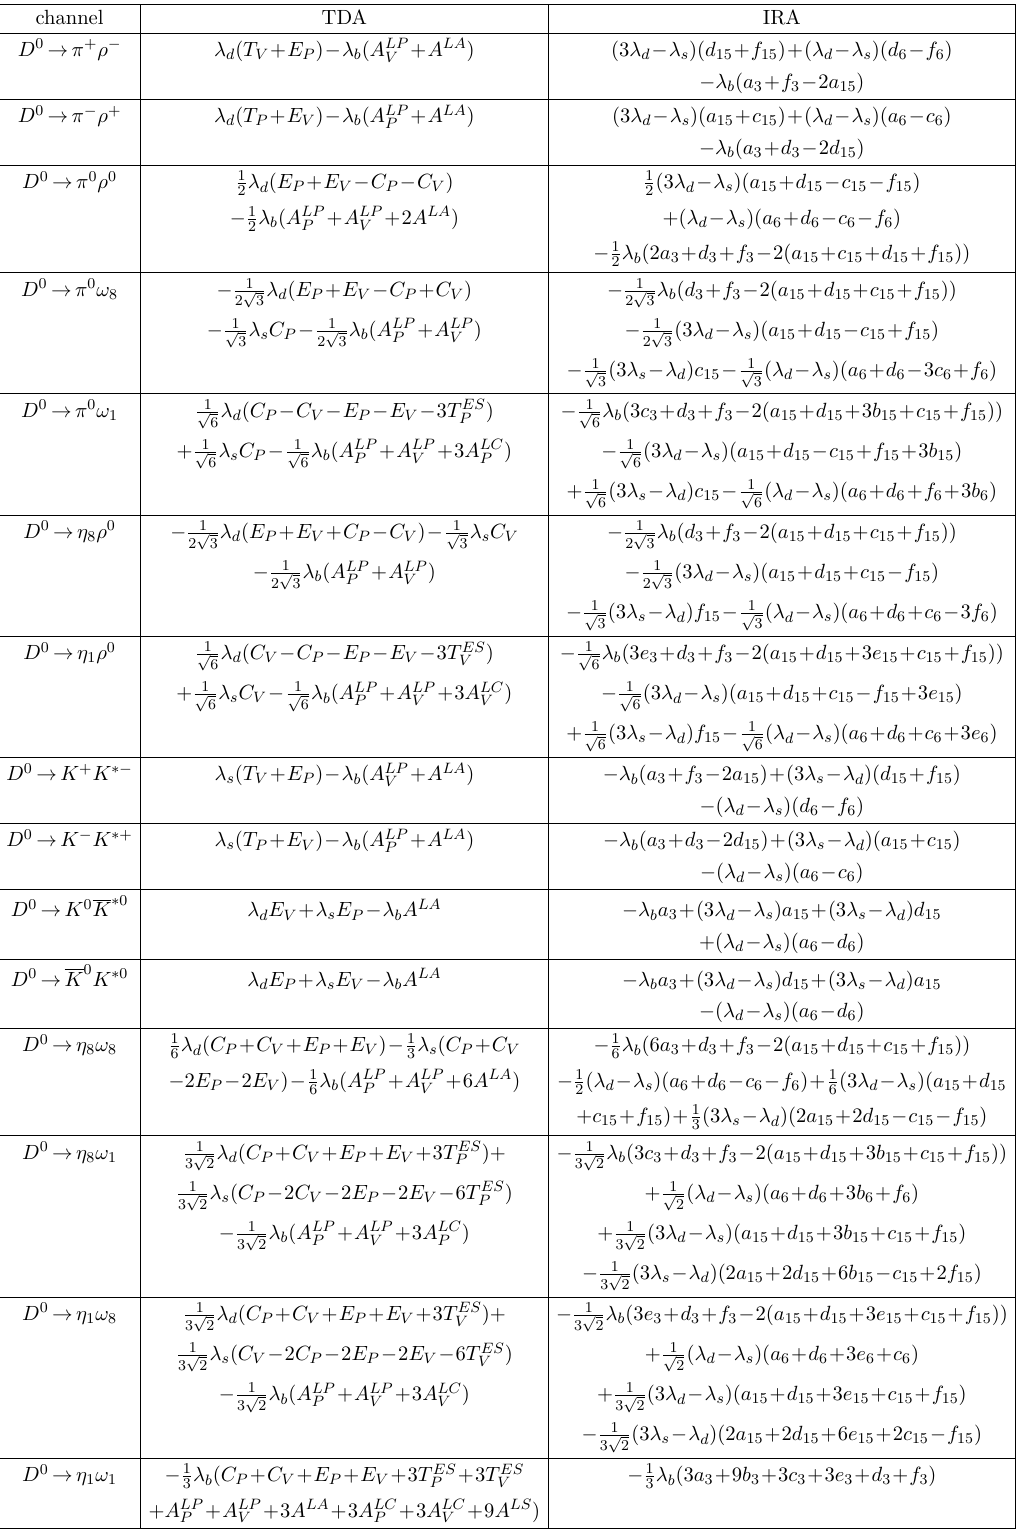
Table 6 . Decay amplitudes of the Singly Cabibblo-suppressed D 0 → PV